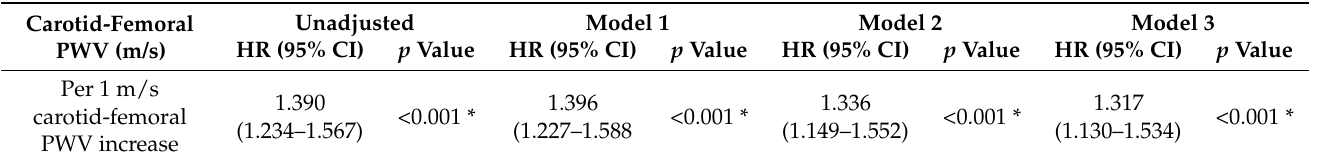
Table 5. Hazard ratio for cardiovascular mortality events by multivariable Cox regression of carotid– femoral pulse wave velocity levels among the 130 hemodialysis